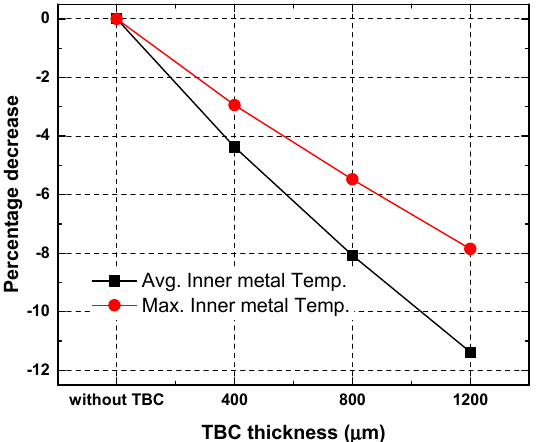
Figure 18. Percentage comparison of the inner metal temperature based on the TBC thickness. Figure 17. Temperature difference between without TBC and three different TBC thicknesses. The thermal stress analysis based on the wall 𝑑𝑇 and thermal expansion coefficient were performed to show the stress contour based on the TBC thickness in Figure 19. The maximum stress was observed in the forward shell section due to the hot gas touching the combustor liner and C-channel due to the lowest wall HTC by the impingement jet. Over- all, the stress level was decreased near the nozzle, in the collision jet, and in the uneven cooling area as TBC thickness increased. This thermal stress analysis revealed that the TBC was effective in reducing the CL metal stress in high temperature regions. As discussed earlier, the method to predict the creep lifetime of the CL by using the calculated wall temperature and von Mises equivalent stress, along with Larson–Miller rupture curves and the creep lifetime of the inner metal and outer metal surface of the CL